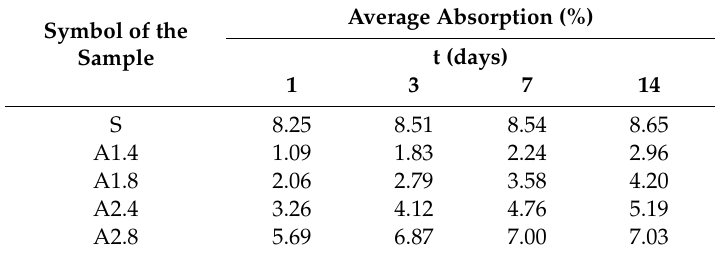
Table 4. Absorption of mortars (%).